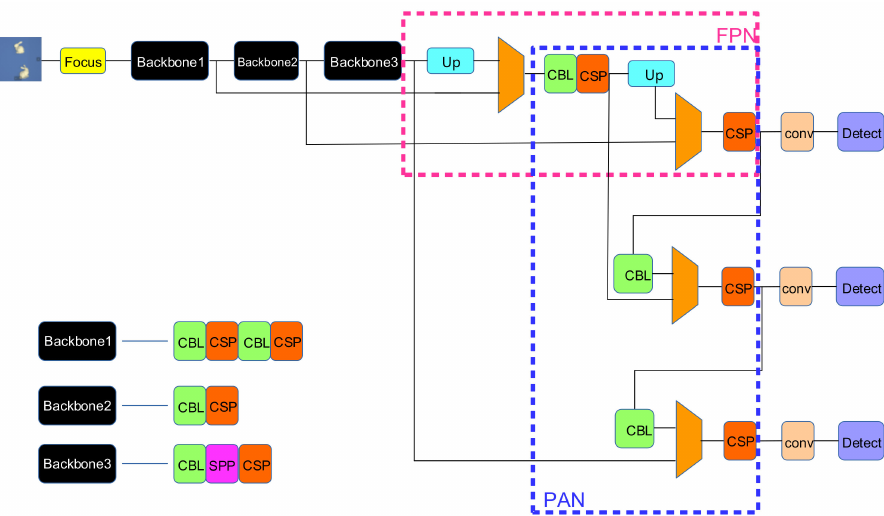
Figure 3. Schematic diagram of optimized YOLOv4 network structure. The algorithm implements the classification of each object in the original image by transferring the highly compressed semantic information down. Then, the information is transmitted upward again to gradually lock the position of the target in the image, which greatly improves the object detection ability of the